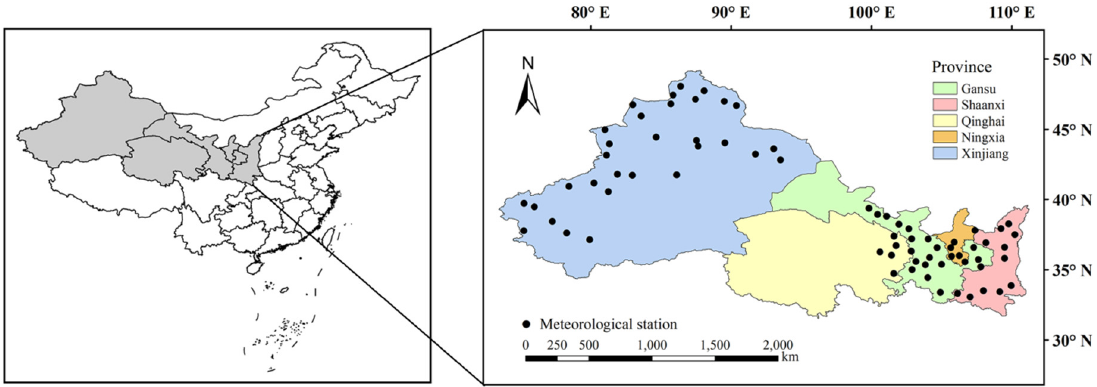
Figure 1. The spatial distribution of each meteorological station in northwest China.